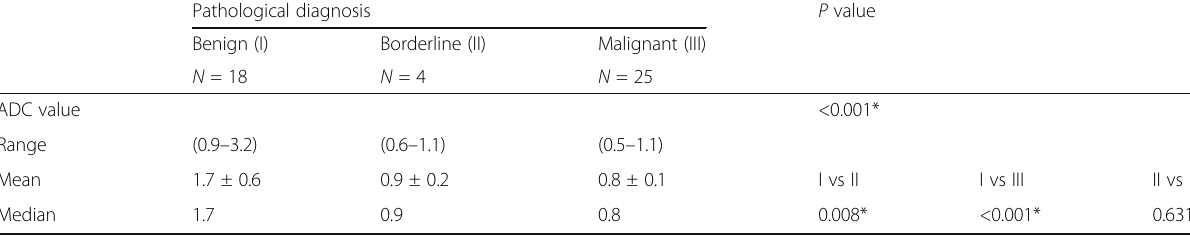
Table 4 Relation between ADC values of the lesion and final histopathological diagnosis Pathological diagnosis